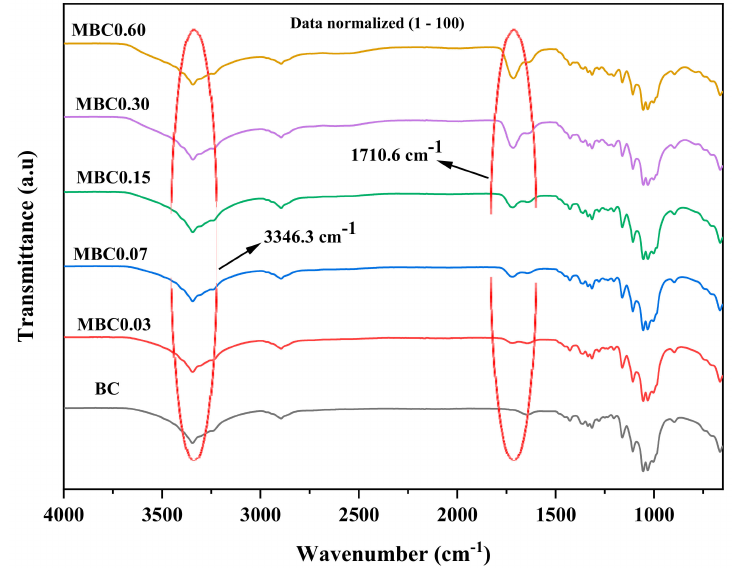
Figure 2. Fourier transform infrared (FTIR) spectrum of the unmodified and modified samples at different citric acid (CA)